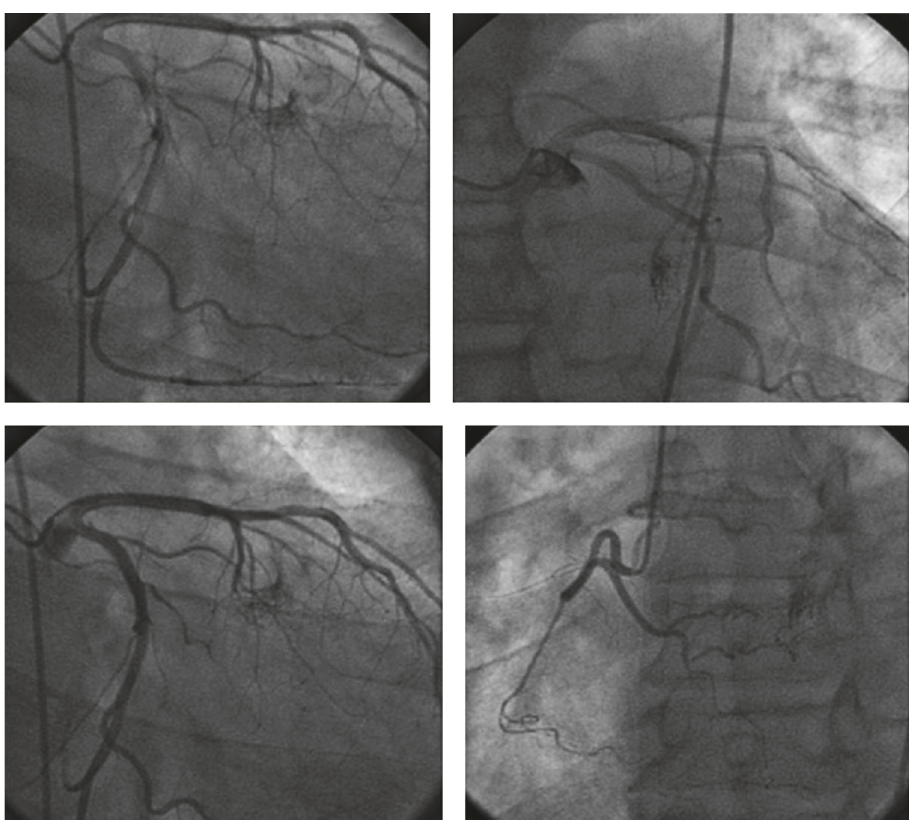
Figure 4: Coronary angiogram showing coronary cameral fistula between the first septal perforator of LAD and LV and between the RCA and LV.